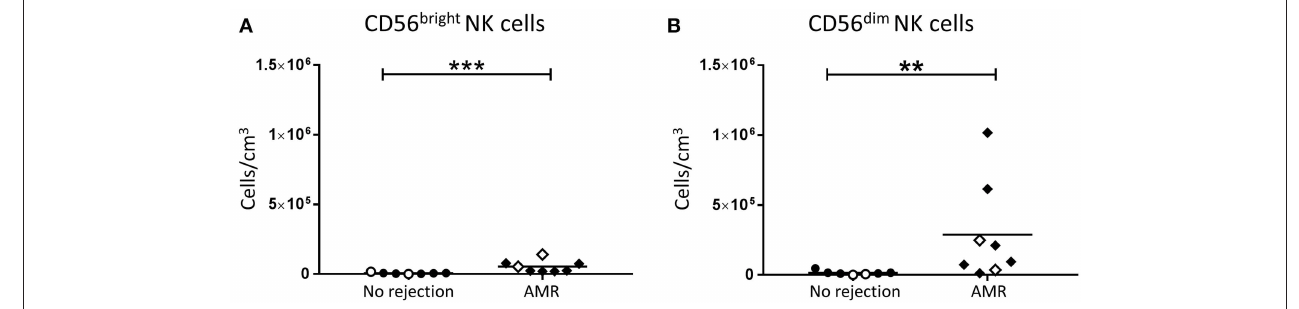
FIGURE 5 | Significantly increased CD56 bright NK cells and CD56 dim NK cells in AMR. Absolute numbers of total (A) CD56 bright NK cells and (B) CD56 dim NK cells in kidney transplant biopsy tissue with histopathological diagnosis of no rejection ( n = 7) and with indication of AMR (AMR; n = 8). Values for individual donors are presented; donors with DSA are identified using open symbols; bars represent means. ** P < 0.01, *** P < 0.001, Mann-Whitney test.